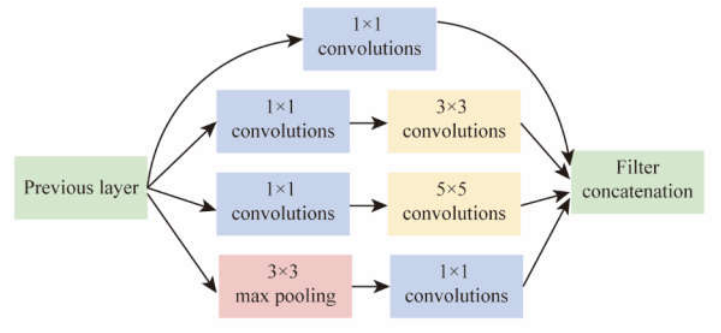
Figure 2. Structure of inception.